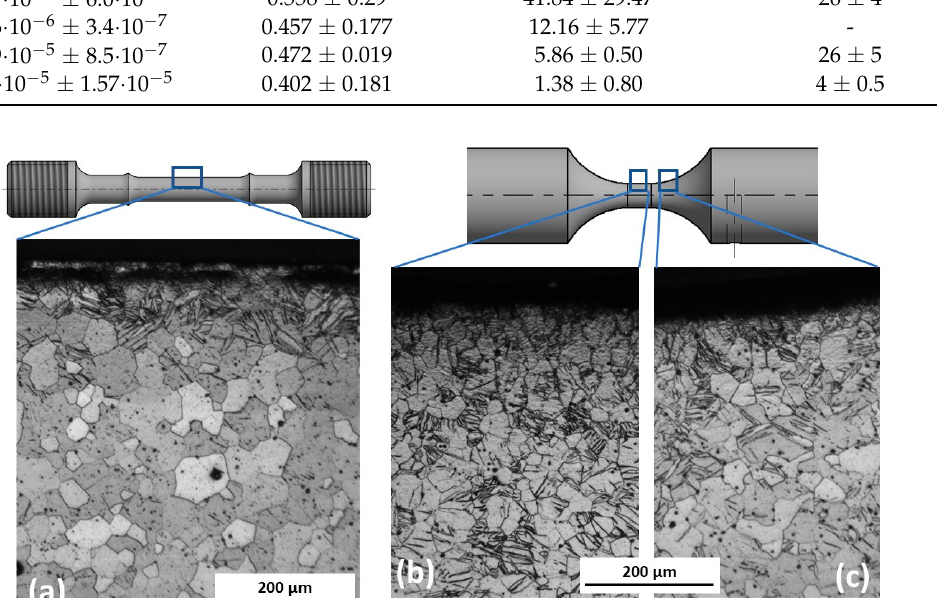
Figure 5. OM of the microstructure, longitudinal section, near-surface region, ( a ) standard specimen, ( b ) miniature specimen in the gauge length, ( c ) miniature specimen beyond the gauge length.